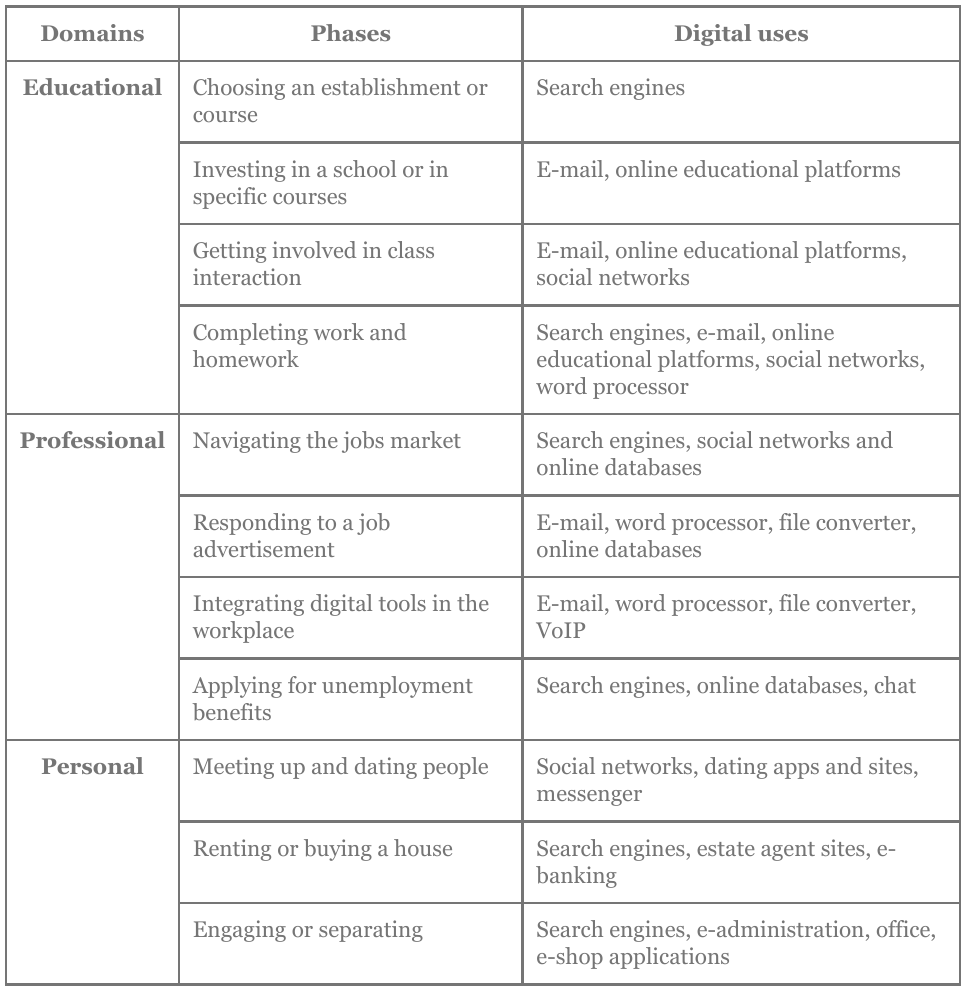
Table 2: Overview of the uses of digital tools in educational, professional and personal